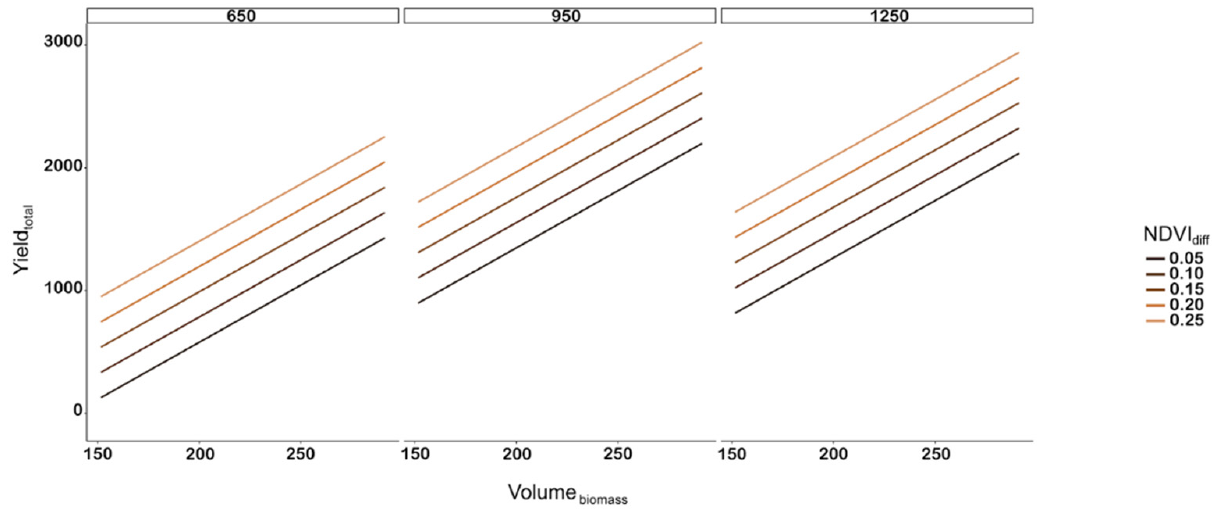
Figure 7. Model predictions for all mushroom yields. Yield total ( Y -axis) versus Volume biomass ( X -axis) are shown for five different NDVI diff values and SDI values of 650, 950, and 1250. The model generated for Lactarius deliciosus (R 2 = 0.3, AIC = 2658.378) is represented in Equation (3), and its parameters are summarised in Table 3.